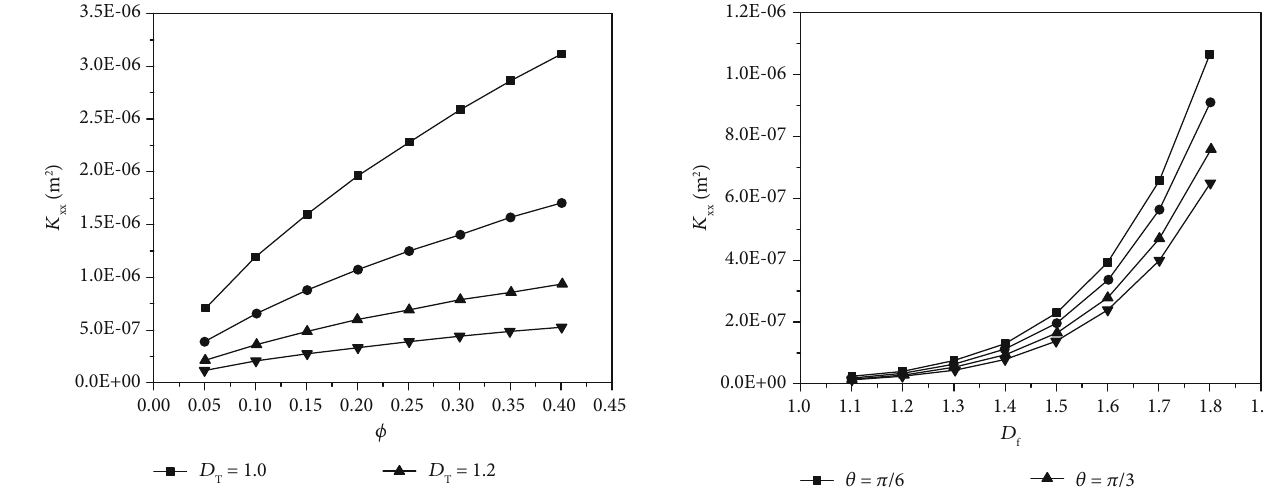
and Φ ( β = 0 : 01 , θ = π /6 , xx